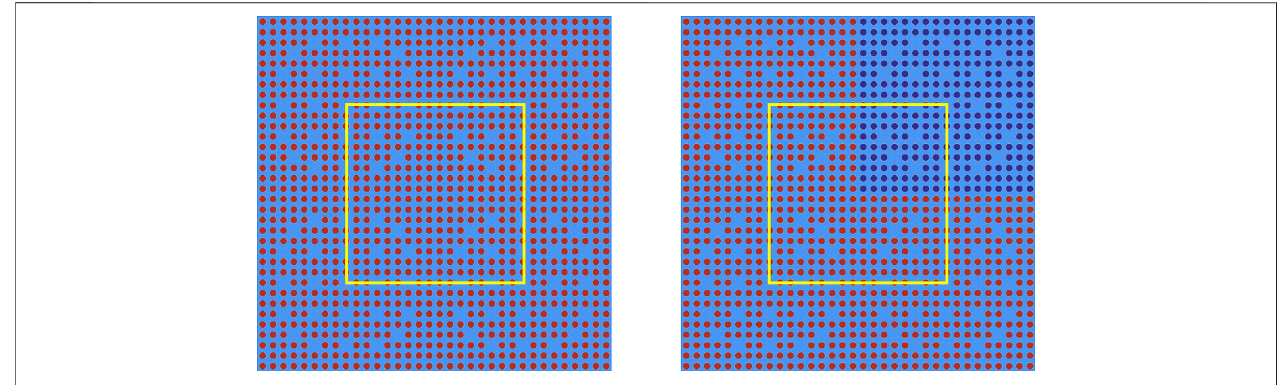
FIGURE 5 | The mini four assembly model to calculate the correction ratio with (A) no perturbation (B) perturbation on the upper right.